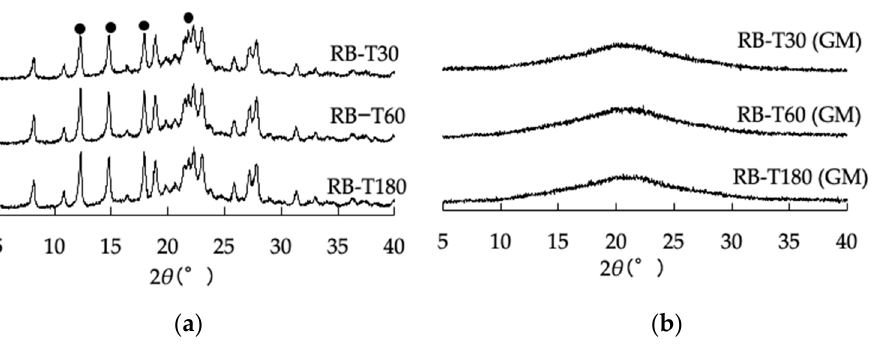
Figure 1. Powder X-ray diffraction patterns of various samples: ( a ) RB-T and ( b ) RB-T (GM).